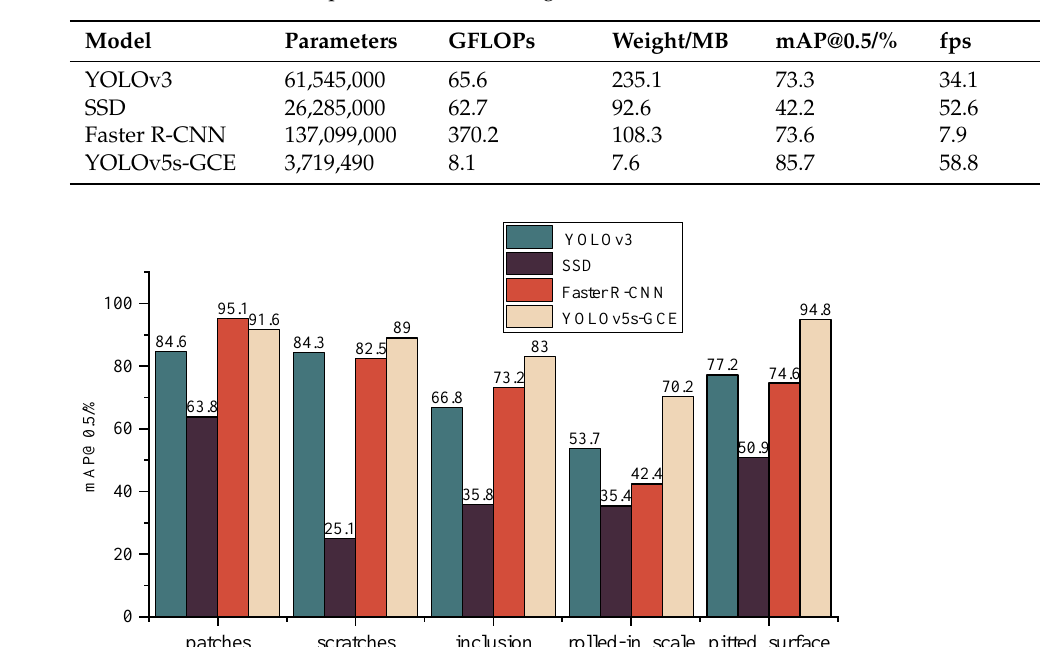
Figure 9. Detection results of various defects by different algorithms.